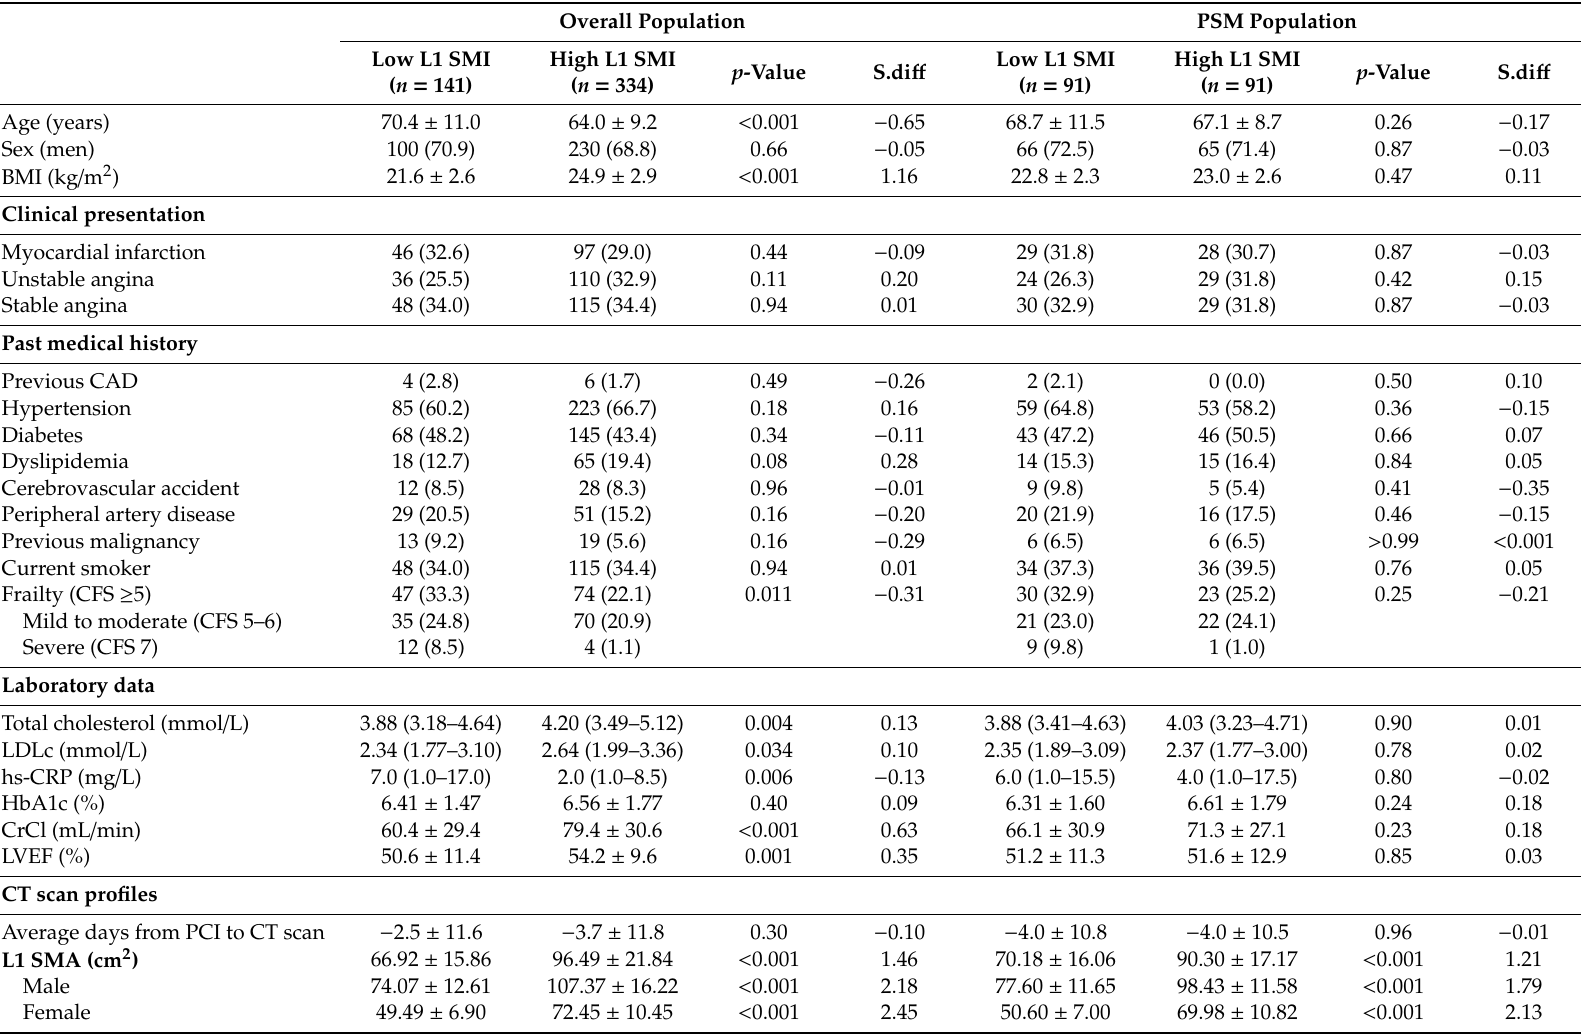
Table 1. Baseline characteristics and procedural